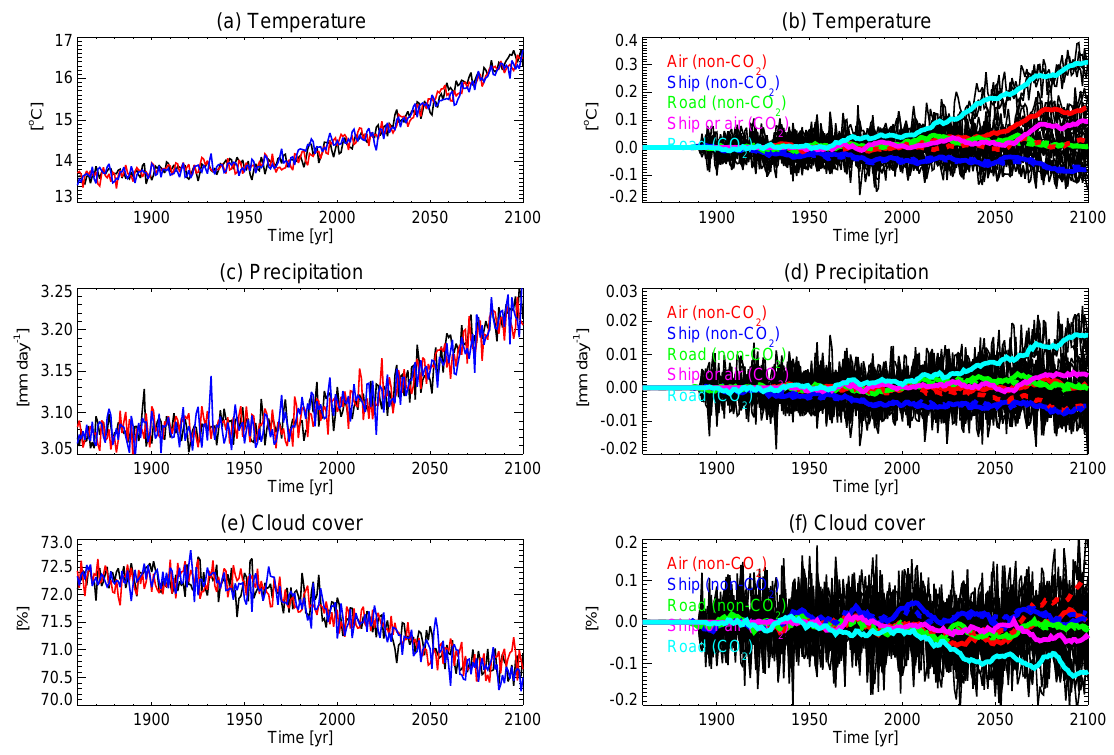
Fig. 9. Left: time series of annual global mean (a) surface air temperature, (c) precipitation, and (e) cloud cover over the period 1860–2100 taking into account the total anthropogenic forcing. The three different lines (black, red and blue) represent the three different members of the ensemble. Right: time series of impact on (b) surface air temperature, (d) precipitation, and (f) cloud cover by road transport, shipping and aviation, separately for their CO 2 , non-CO 2 and non-CO 2 * impact (the non-CO 2 * impact is indicated by the dashed lines). The thin black lines indicate the individual impact from each of the three members of the simulation, and the thick lines indicate the 11-year running average of the ensemble mean.